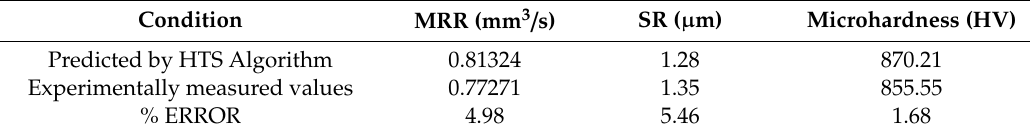
Table 6. Validation results for case studies III and